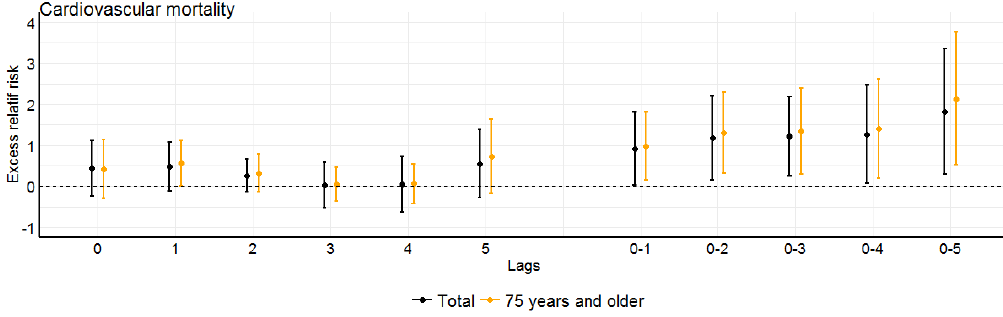
Figure 2. Excess relative risk (ERR) and 95% confidence intervals (95% CI) for non-accidental and cardiovascular deaths associated with a 10 µg m −3 increase of NO 2 concentrations, according to age (total population and ≥75 years) using different lags (single and cumulative) in single pollutant models (18 areas, metropolitan France,